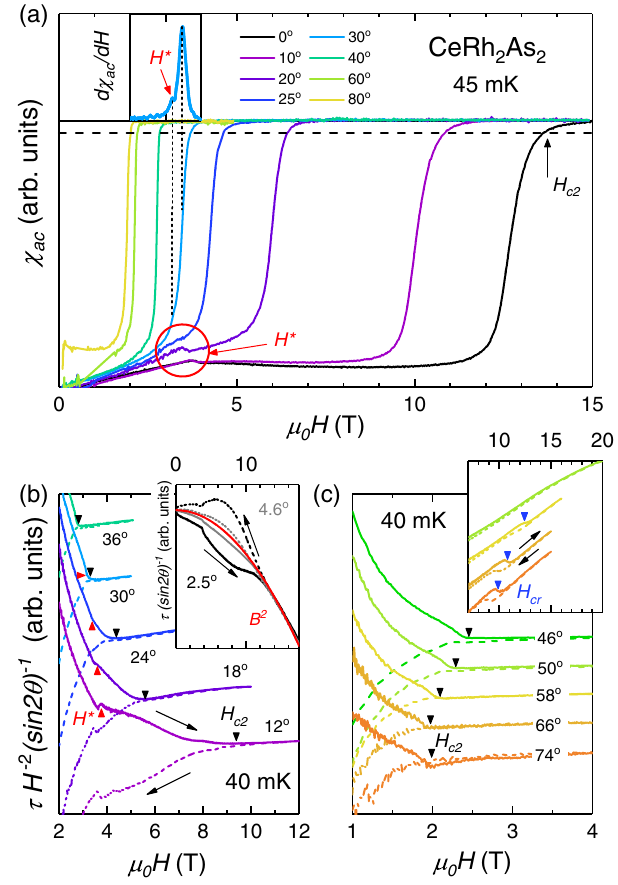
FIG. 1. Magnetic field dependence of magnetic susceptibility and torque for different field directions. (a) Magnitude of the ac susceptibility χ at 45 mK for different angles as indicated. θ ¼ ac 0 ° corresponds to μ k c . The bump labeled as H (cid:2) is the 0 H transition between SC1 and SC2. The inset shows the derivative of the curve at 30°, indicating that H (cid:2) is still present at that angle. The dashed horizontal line indicates the value at which H is c 2 defined. (b) Magnetic torque divided by H 2 sin ð 2 θ Þ at 40 mK. The inset shows the torque for 2.5° and 4.6° where the hysteresis of τ at low angles is visible. Additionally, the red line gives the expected B 2 dependence. (c) Torque divided by H 2 sin ð 2 θ Þ for angles close to the plane. The inset in (c) shows the additional ≈ 9 T. In (b) and (c) curves are phase transition appearing at H cr shifted for